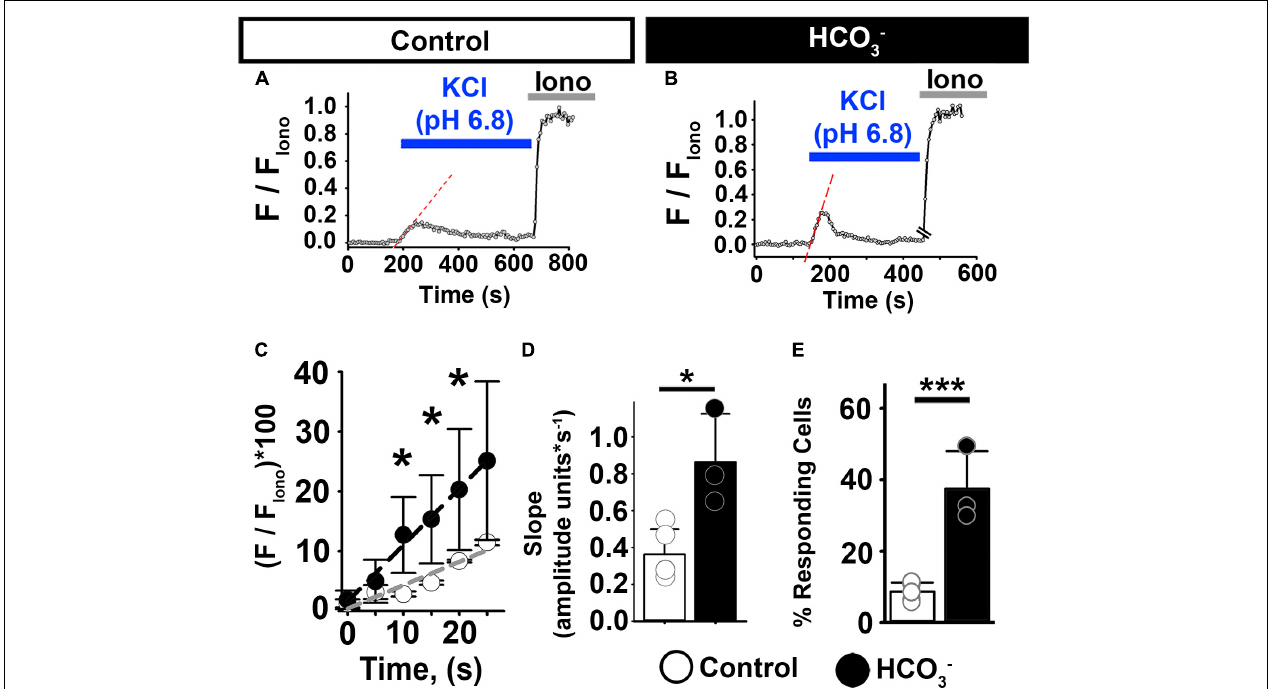
FIGURE 4 | HCO 3 − enhances [Ca 2 + ] i responses to KCl in human epididymal sperm. (A,B) Representative traces of [Ca 2 + ] i responses to 50 mM KCl at pH 6.8 in epididymal human sperm in non-capacitating conditions (A) without and (B) after pre-incubation with HCO 3 − . (C) Linear fit of the averaged normalized fluorescence in the first 20 s after KCl addition. (D) Graph of slope values of the best-fit regression line for each condition. Mean values were as follows: control, 0.36 ± 0.137 amplitude units * s − 1 (4 samples, 62 sperm); and HCO 3 − , 0.86 ± 0.260 amplitude units *s − 1 (3 samples, 52 sperm). (E) Graph of the percentage of responsive sperm. Mean values were as follows: control, 8.72% ± 2.54 (4samples, 62 sperm); and pre-incubation with HCO 3 − , 37.5% ± 10.54 (3 samples, 52 sperm). * P < 0.050, *** P < 0.001 by independent t-test. Error bars indicate standard deviation. Iono = 5 µ M Ionomycin + 2 mM Ca 2 +